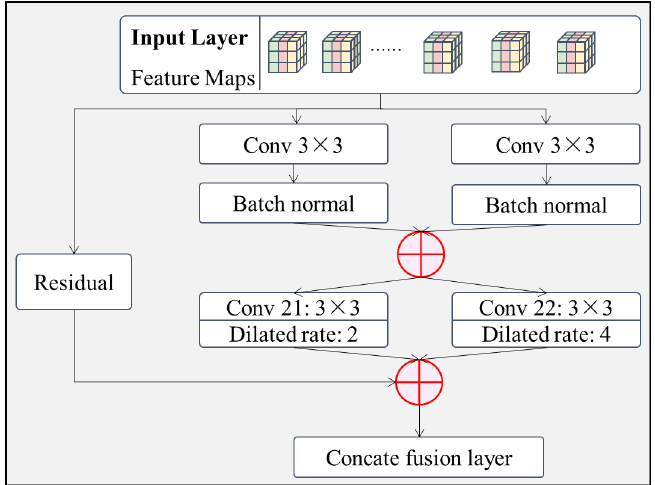
Figure 5. Structure of the residual dilated convolution feature extraction